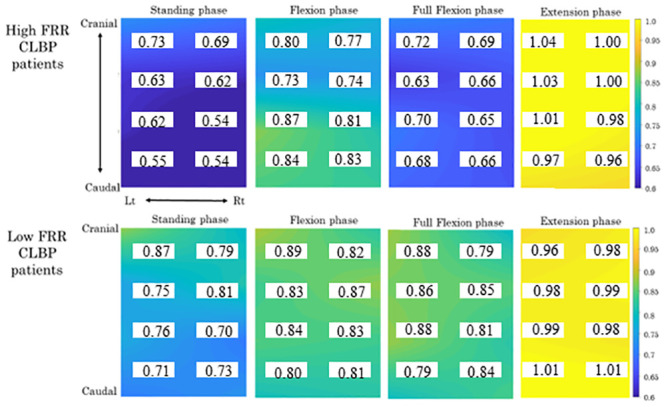
The differences in the topographical maps of the RMS value between the low-FRR and high-FRR groups.Representative topographical maps of the electromyographic RMS values recorded from the bilateral erector spinae for a high-FRR patient and a low-FRR patient in the standing phase, flexion phase, full flexion phase, and extension phase of the standing forward bending task. Blue indicates low muscle activity, and yellow indicates high muscle activity. The RMS values of the low-FRR patient were lower than those of the high-FRR patients in the standing phase and full flexion phase. The RMS value of each channel was insert in topographical maps. The changes in the RMS value between the flexion phase and the full flexion phase in the low-FRR patients were smaller compared to those of the high-FRR patients.